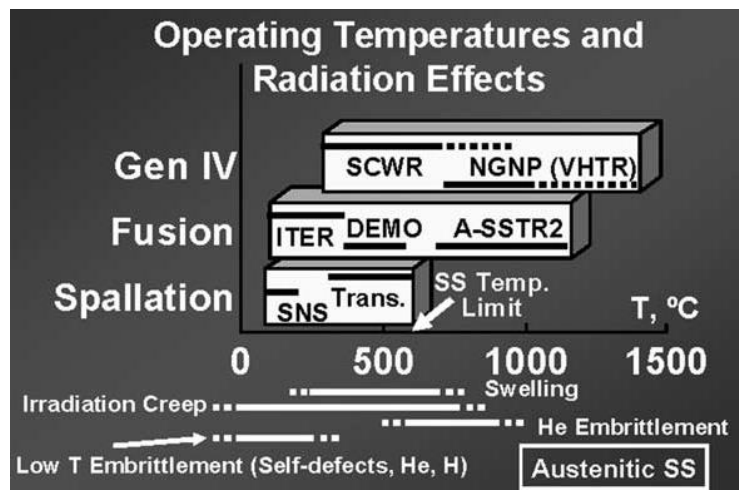
Figure 3. Overlap in temperatures for fusion, fission and spallation facilities. This figure is taken from [18]. “In Table 3 is it possible read also the main operating parameters of these three types of plants [78] .”